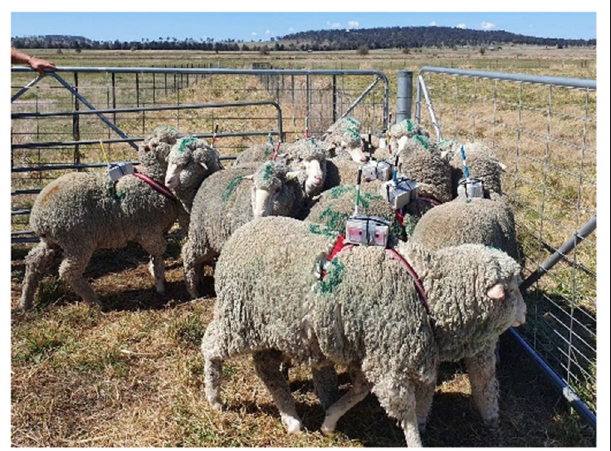
FIGURE 3 | RTK rovers fitted on the backs of